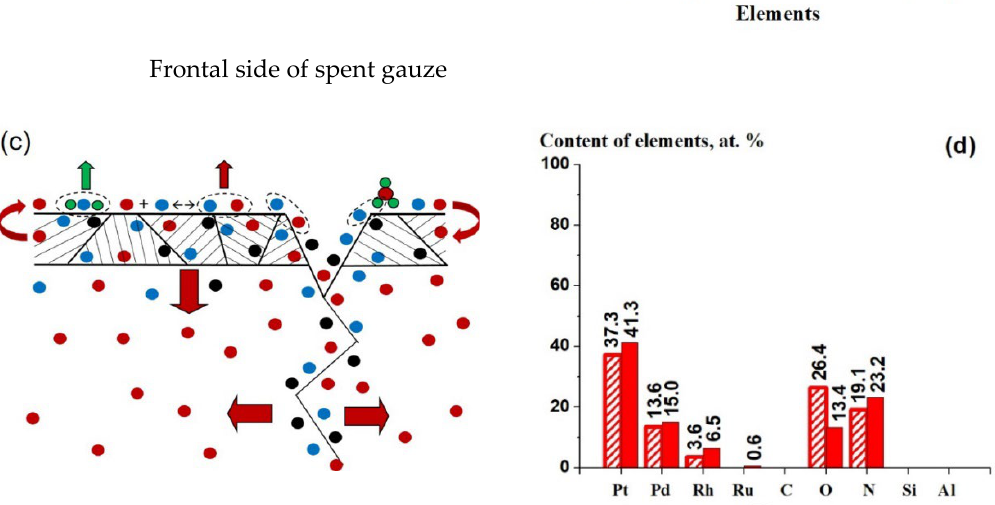
Figure 8. Reaction schemes of NH 3 oxidation with oxygen; the surface with adsorbed O ads , N ads , NH 3 (ads) and subsurface regions of the catalyst with absorbed C ab , O ab and N ab atoms for the back ( a ) and frontal ( c ) sides of the Pt–Pd–Rh–Ru gauze during NH 3 oxidation. The elemental composition of gauzes under the surface films (OH ad , CO ad , C gr , Rh 2 O 3 ) according to XPS (shaded bars) and EDS (solid bars) for the back ( b ) and frontal ( d ) sides of the gauze after NH 3 oxidation at 1133 K.